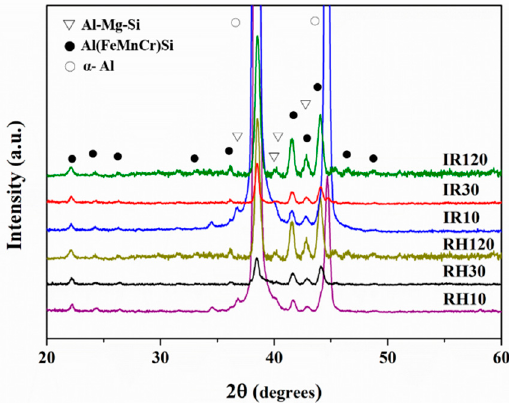
Figure 8. X-ray diffraction patterns of specimens treated under various solution heat treatment conditions.